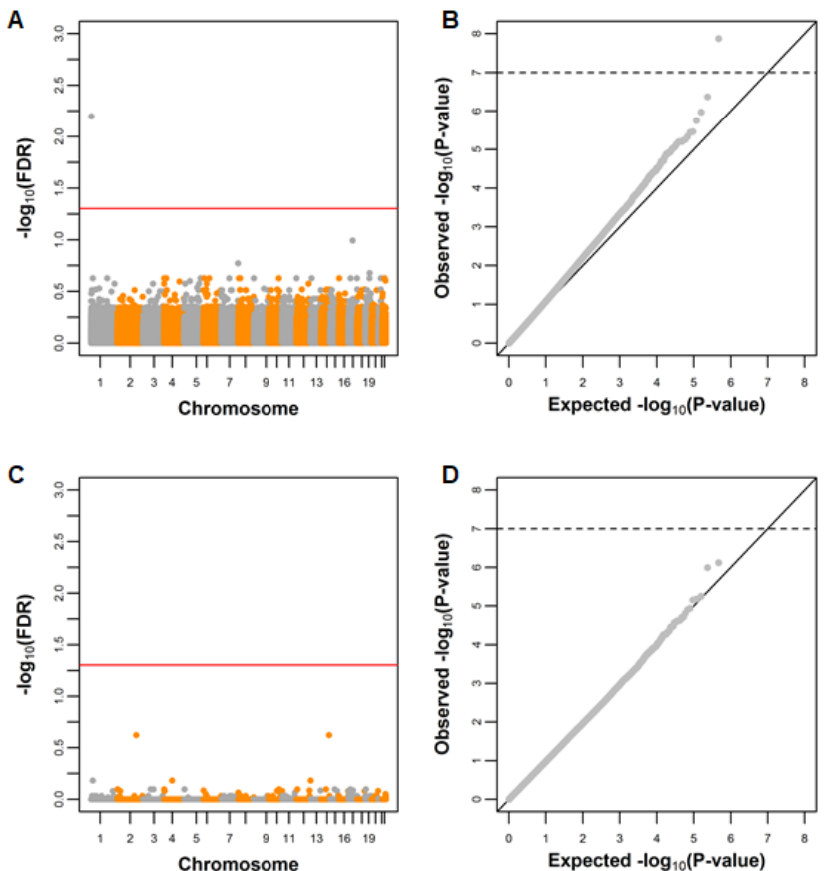
Figure 1. Manhattan ( A , B ) and Q-Q plots ( B , D ) of the breastfeeding EWAS at age 7. In ( A , B ), methylation was compared between never vs. ever breastfed individuals; in ( C , D ) methylation was compared according to breastfeeding duration (in categories, assuming a linear trend). Both models were adjusted for cell composition, batch, child genetic ancestry (two principal components), mother’s education, parity, age at birth, folic acid supplementation, maternal smoking, gestational age, type of delivery, birthweight, child sex and age at blood